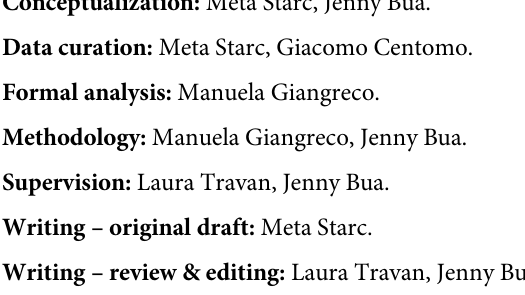
S1 Table. Distribution of SGA and EUGR according to different growth charts in VLBW who were back transfered from our NICU to local hospitals between 33 and 35+6